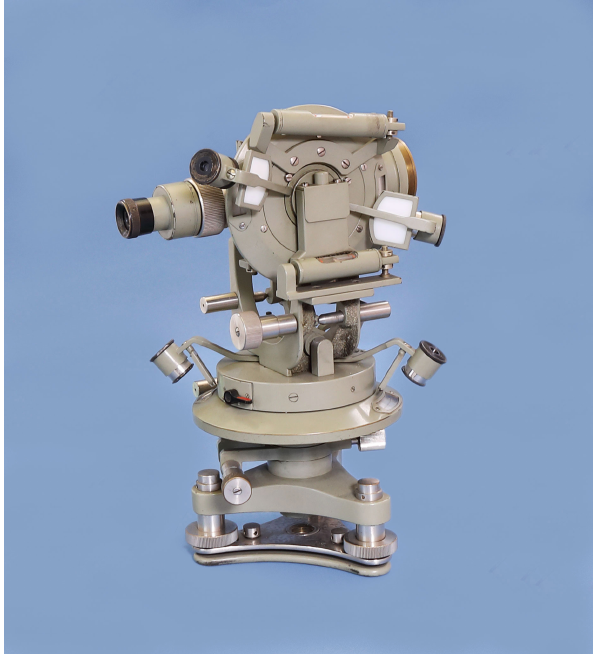
Figure 6. Compass theodolite by Srb & Štys company (photo sup- plied by https://www.surveyinginstruments.org).